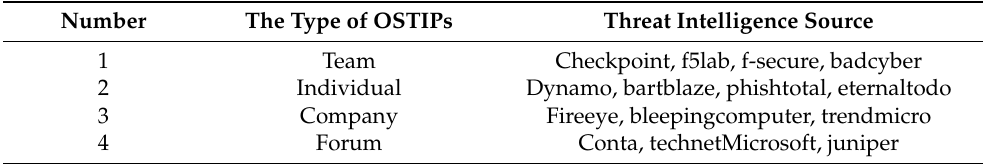
Table 5. Some sources of threat intelligence dataset.